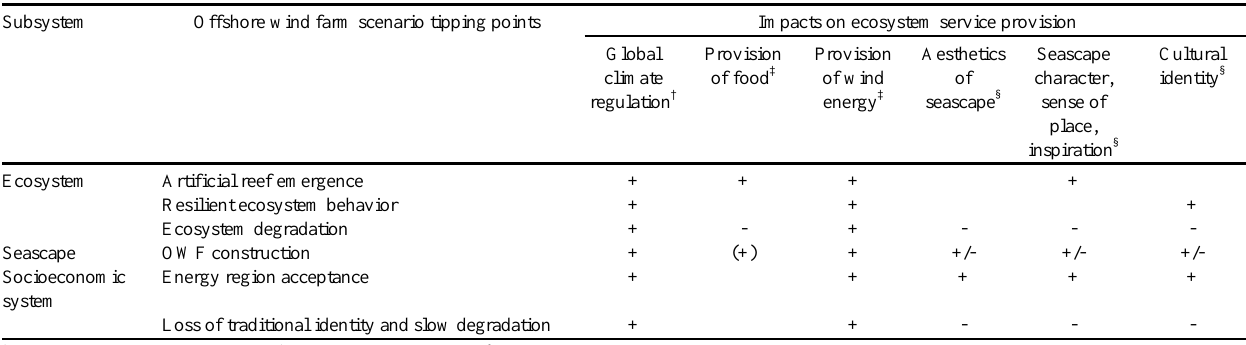
Table 2 . Tipping points for regime shifts in the respective subsystems and the impact of the respective trajectories on selected ecosystem services.